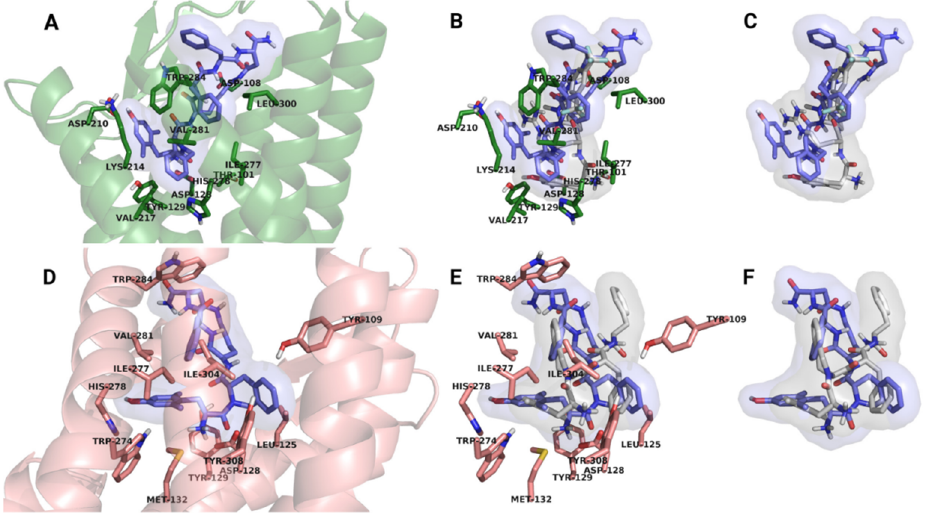
Figure 3. Representative low-energy docking poses of the examined compounds with active ( A – C ) and inactive DOR ( D – F ). Compounds 1 for the active and 5 for the inactive DOR are shown as examples. Amino acid side chains that line the binding pocket of active and inactive DOR are shown in pink and green stick representations, respectively. Non-polar hydrogen atoms are omitted for clarity.